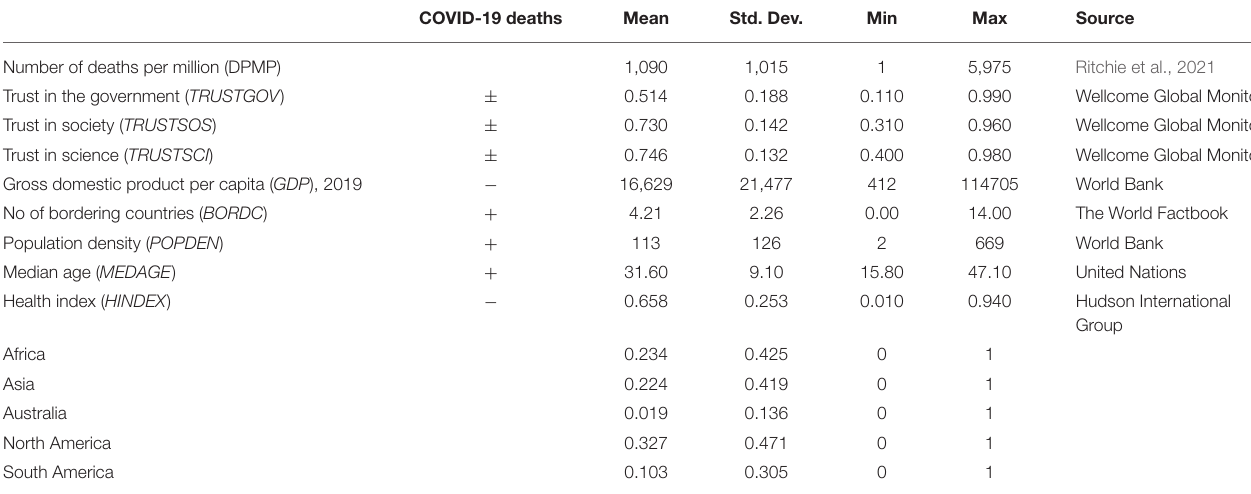
TABLE 1 | Summary statistics for the sample variables.